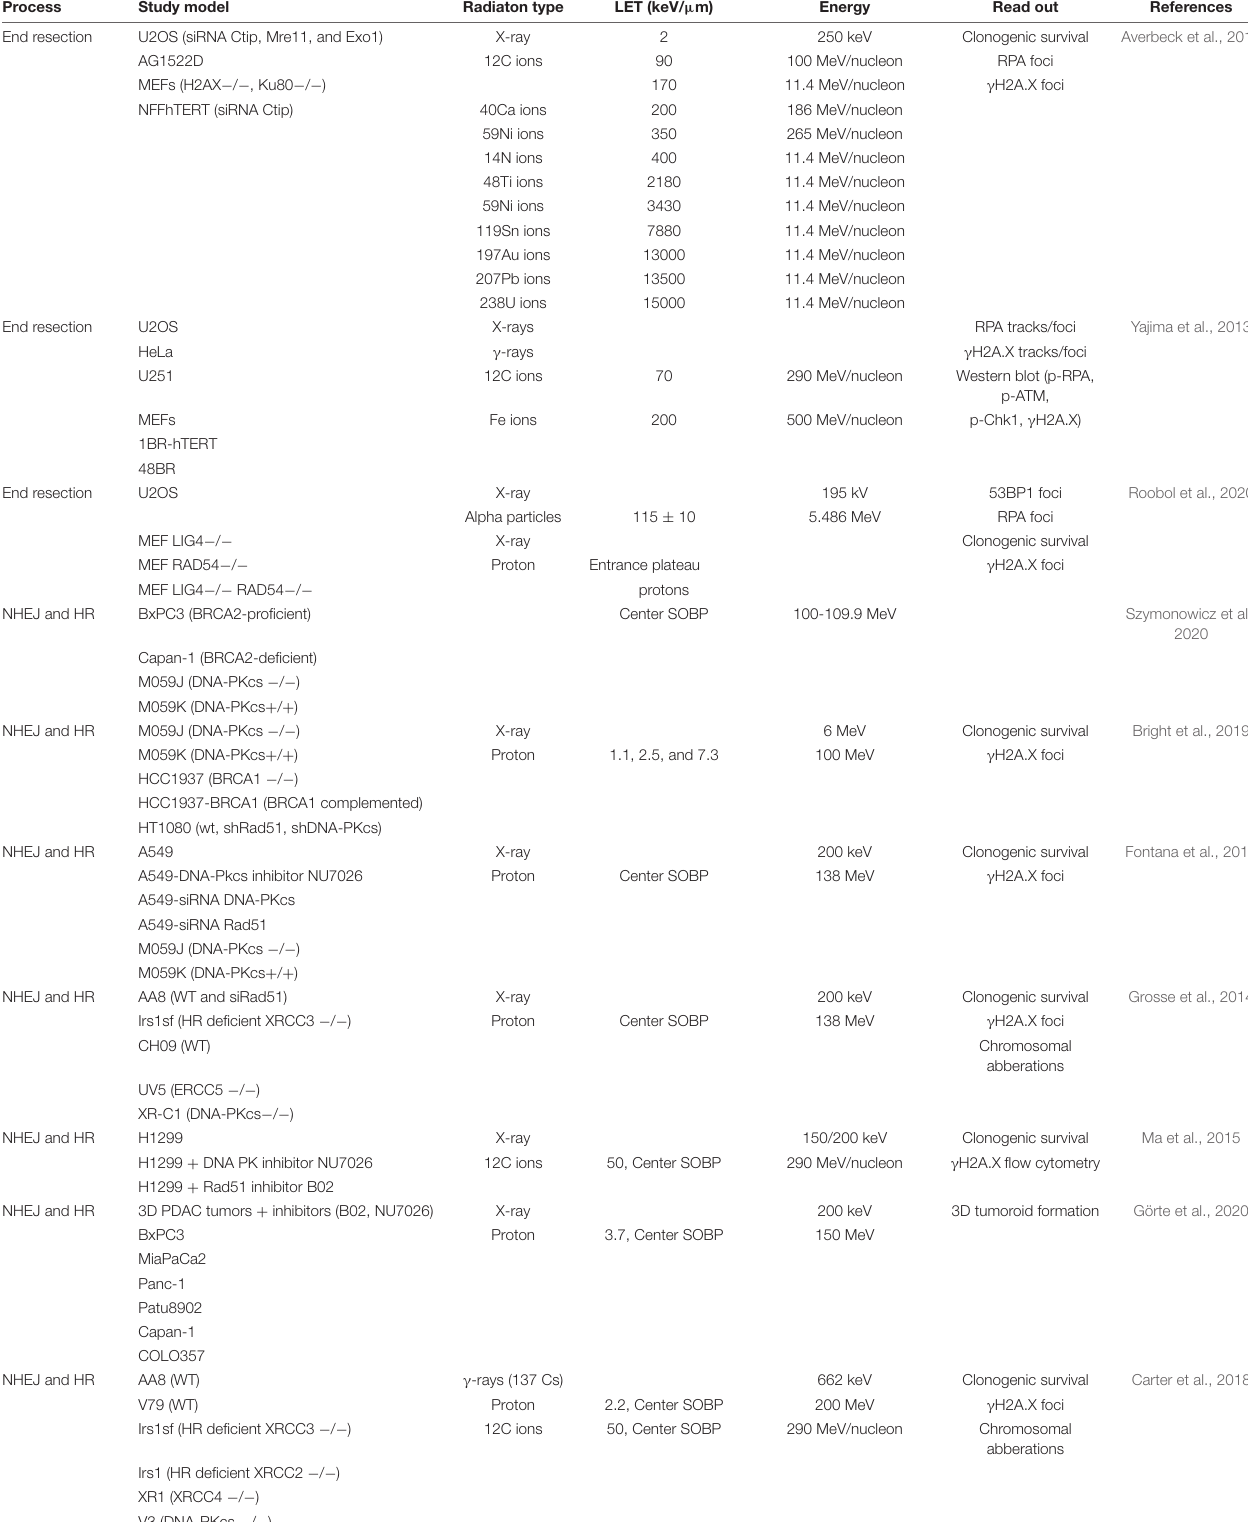
This table provides an overview of the radiation parameters and biological models used in the cited studies: the specific DNA repair process studied, cell model used (including information about protein knock-out or knockdown), radiation type, LET, energy of the particles, and the read-out that was used to study the indicated process.